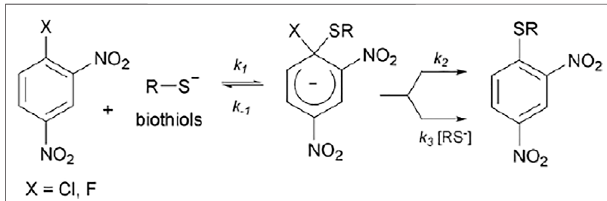
FIGURE5| GeneralreactionmechanismforaS N Arbetween1-halogen- 2,4-dinitrobenzene with a biothiol in the anionic form.